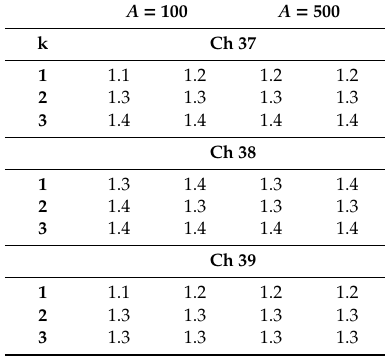
Table 18. Comparison of accuracies (in m) for Test #6a. For each value of A , the first and second data columns refer to the iBeacon and Eddystone protocol respectively. The three advertising channels are referred to as Ch 37, etc., and the number of neighbors in the WKNN algorithm, as k . A = 100 A = 500 k